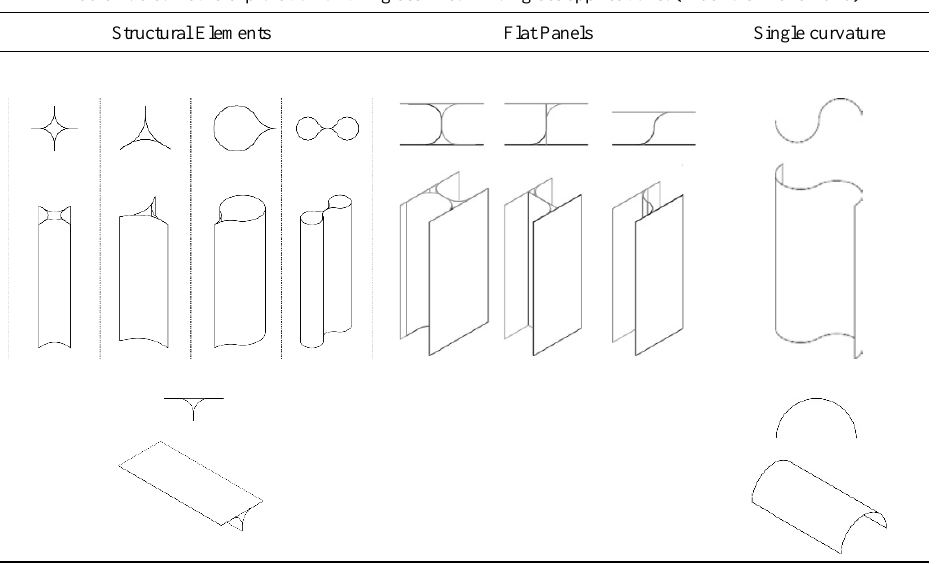
Table 1: Geometric exploration of thin glass in common glass applications. (Ribeiro Silveira 2016)